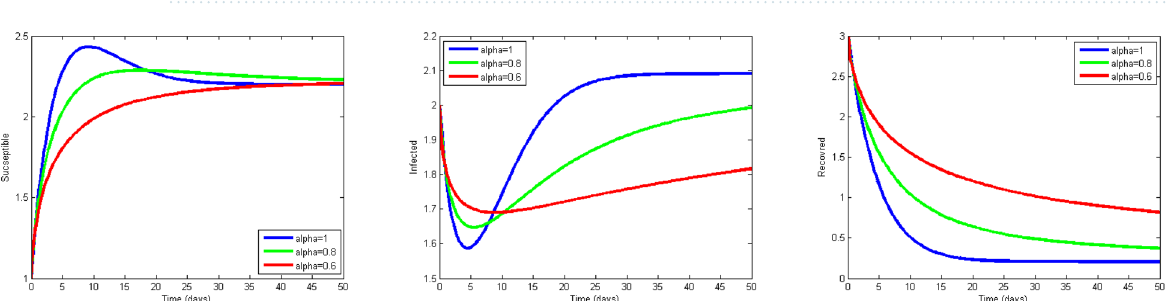
Figure 7. Dynamics of the system (3.2) for α = 0.6 .